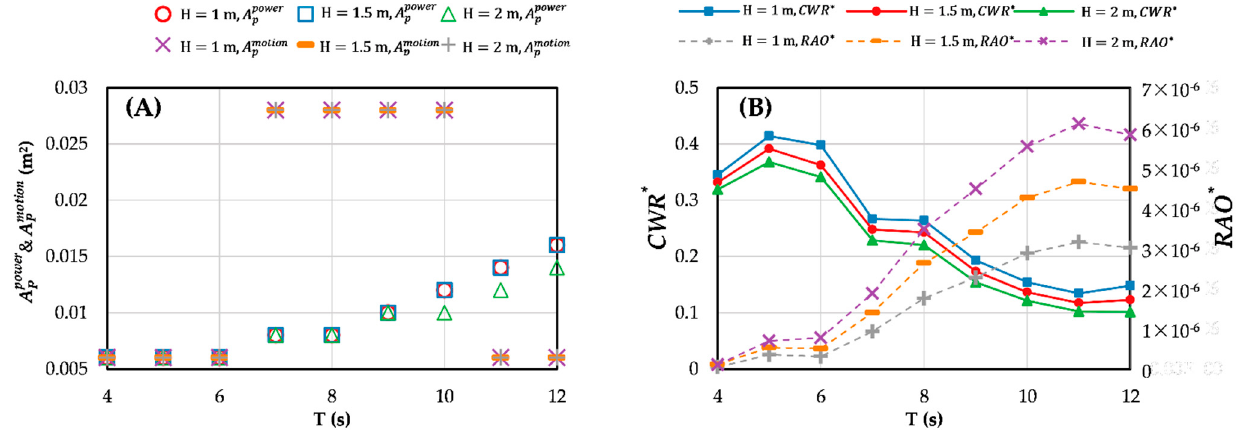
Figure 8. Variation of optimal piston area and corresponding performance under different wave states. ( A ) A Ppower and A Pmotion under different wave conditions, ( B ) CWR * and RAO * under differ- states. ( A ) A power and A motion under different wave conditions, ( B ) CWR* and RAO* under different P P ent wave conditions. wave